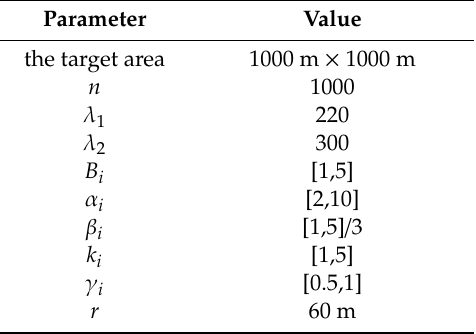
Table 2. The value of the simulation parameters.